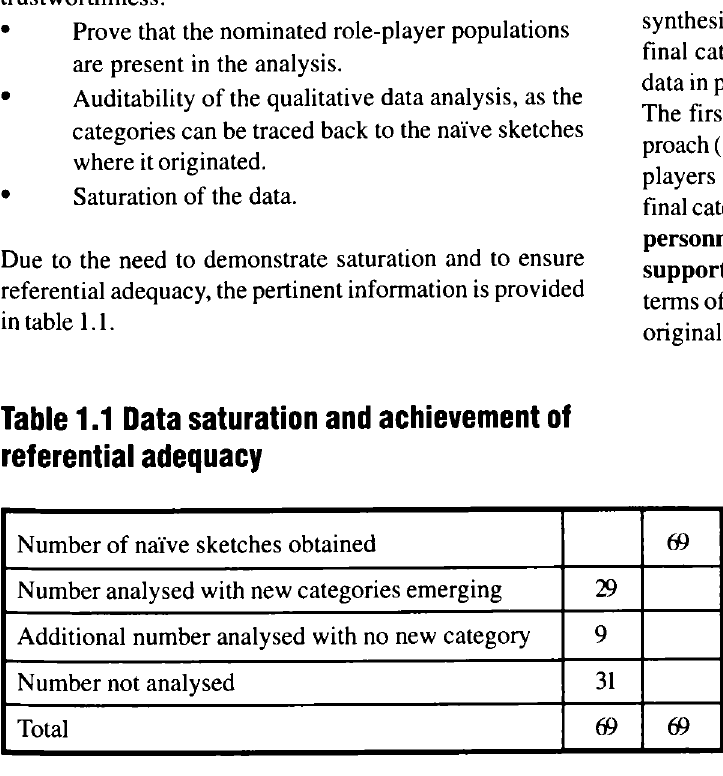
Table 1 .1 Data saturation and achievement of referential